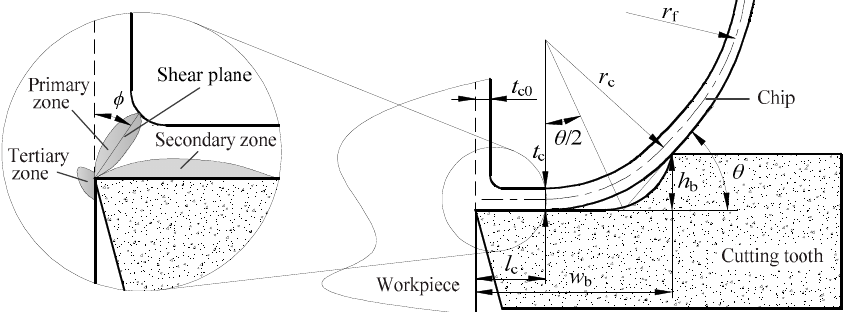
Figure 2. Deformed model of the chip across the chip breaker.